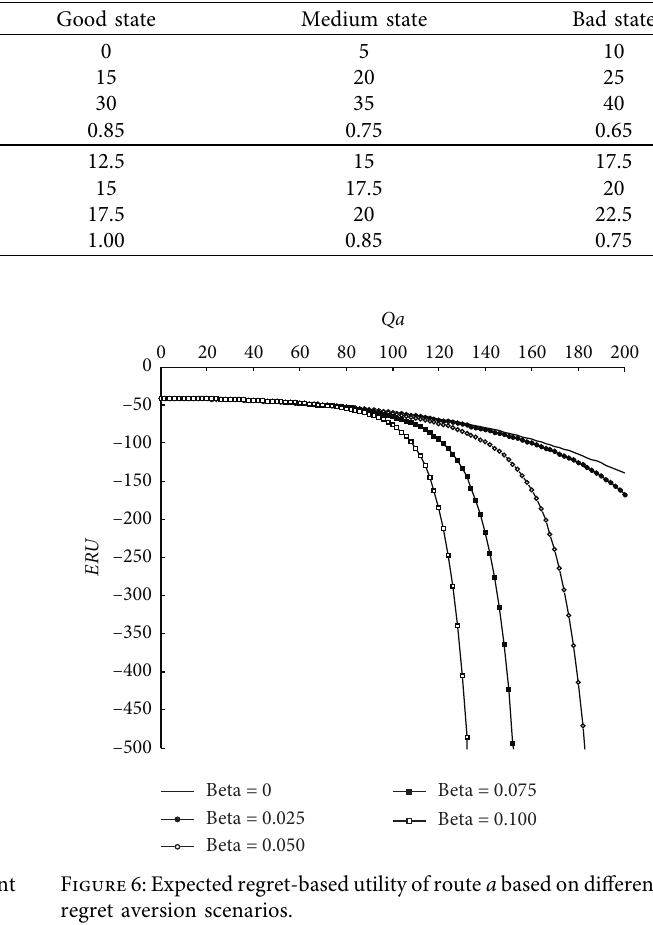
Table 1: Random travel time and capacity reduction parameters for the three states.